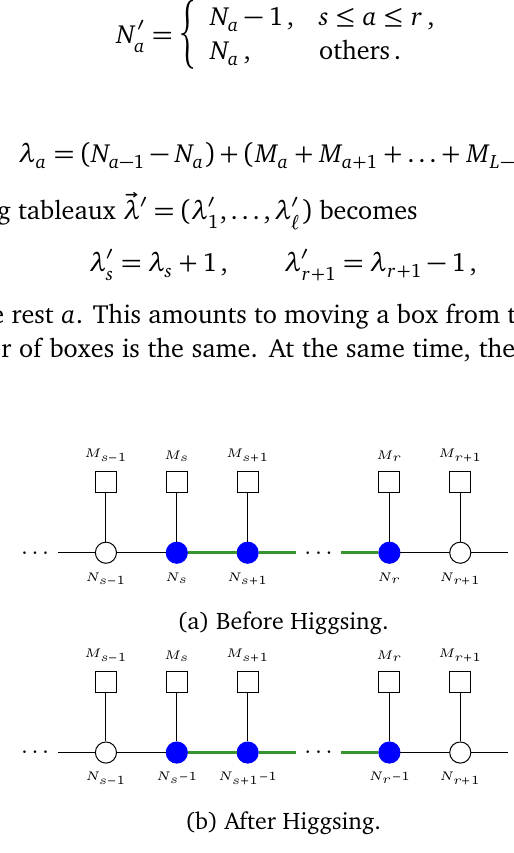
Figure 7: Coulomb branch